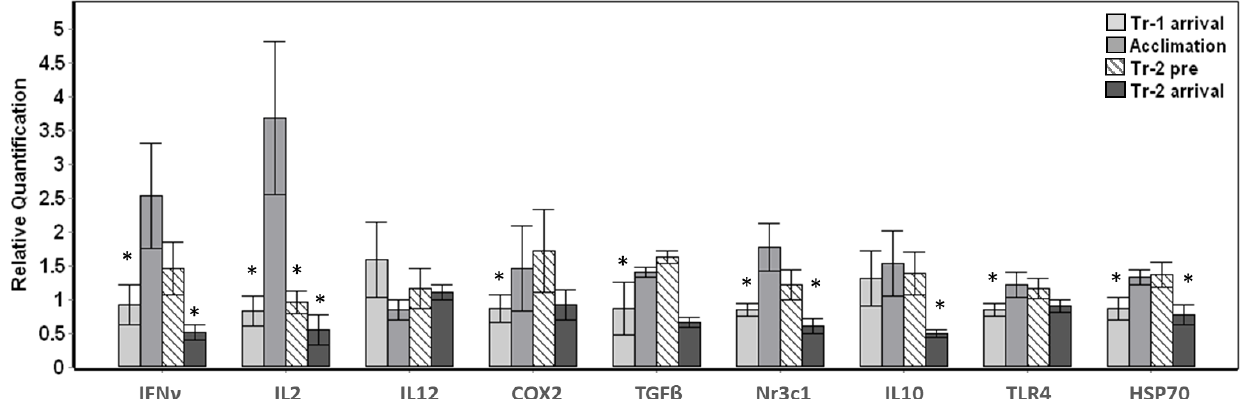
Figure 1. Gene expression changes in whales transported and acclimated to Mystic Aquarium. The relative quantification values were obtained in relation to the average expression (y = 1) for each gene across all the time points. Transport-1 arrival samples were taken upon arrival (Tr-1 arrival) on the stretcher. Acclimation samples were taken under behavioral control during their stay (Acclimation). Animals were sampled again on the stretcher before return transport (Tr-2 pre), and after they arrived at their destination (Tr-2 arrival). Gene expression time points that showed significant differences when compared to acclimation samples are indicated with an asterisk (Posthoc pairwise test with Sidak correction, * p < 0.05). Error bars represent standard error of means for multiple individuals.